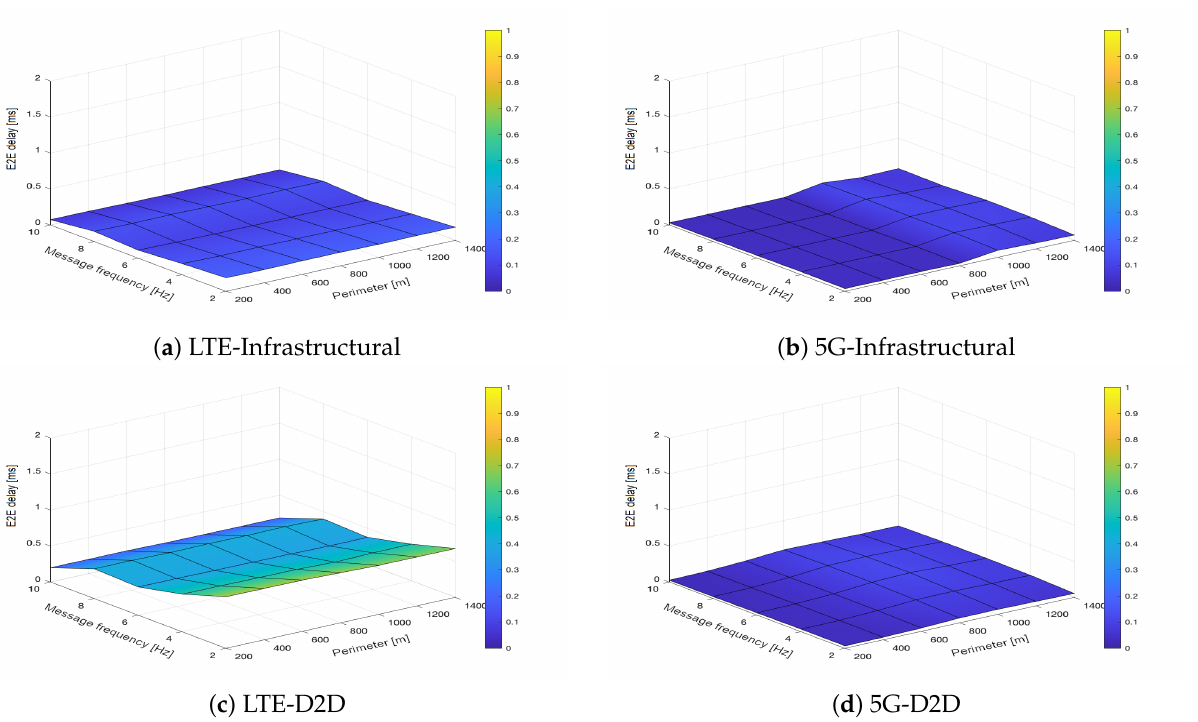
Figure 10. E2E latency simulated for all the investigated modes of the 4G-based and 5G-based C-V2X technologies and traffic intensity of 750 vehicles per